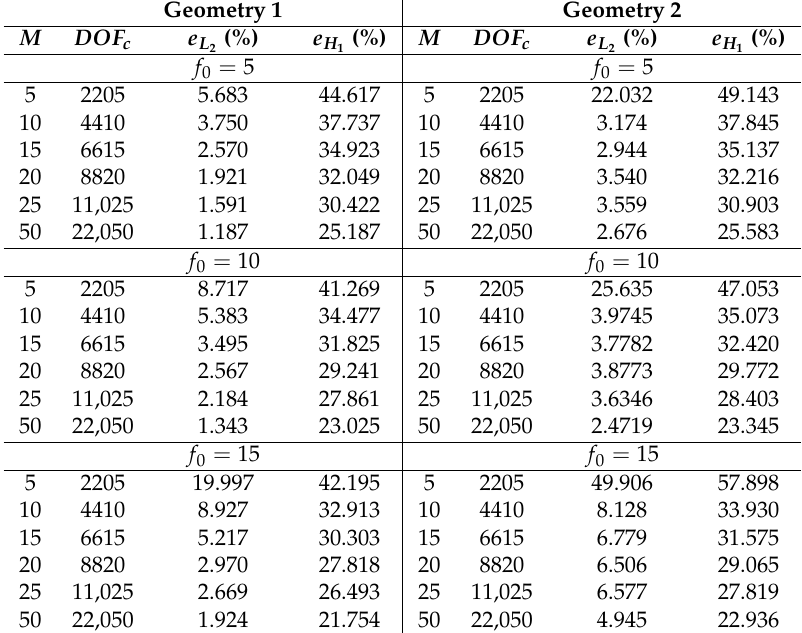
Table 1. Relative errors for Continuous Galerkin Generalized Multiscale Finite Element Method (CG-GMsFEM) with different number of multiscale basis functions M . Left: Geometry 1. Right: Geometry 2.